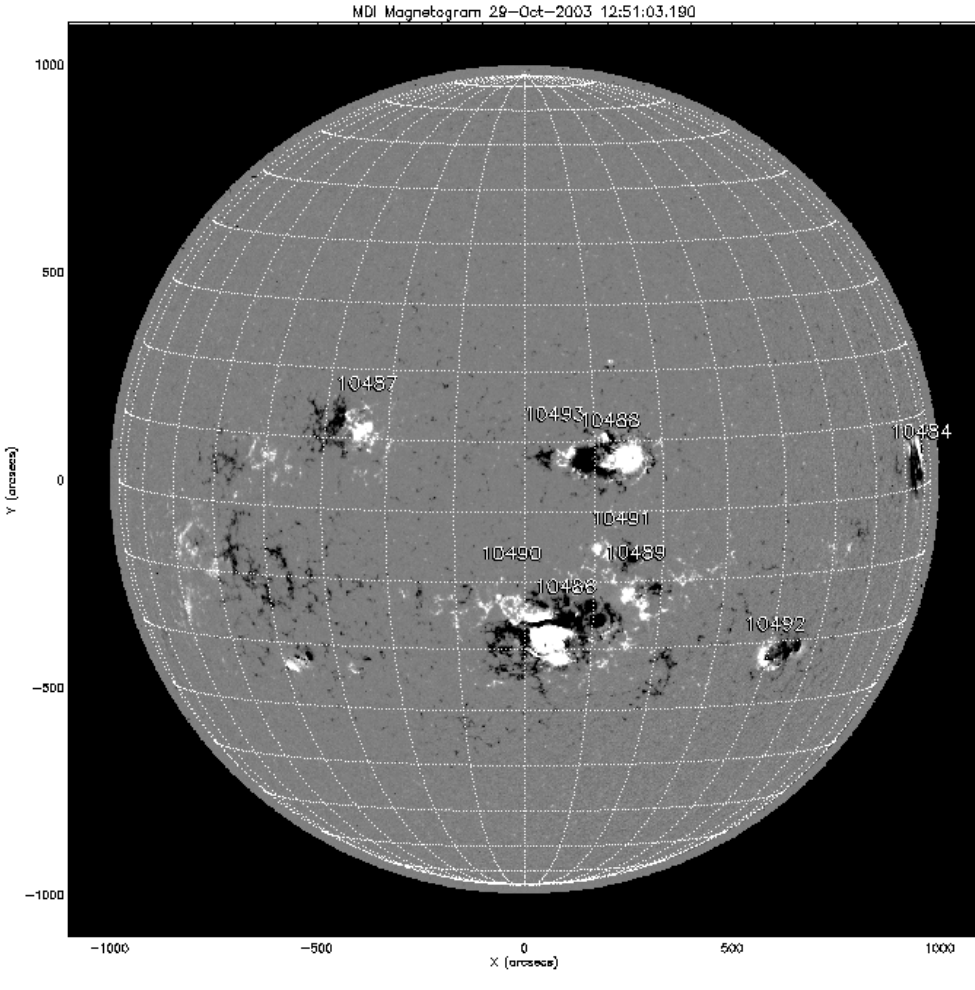
Fig. 6. Magnetogram showing the solar magnetic field on 28 October 2003, at about 12:51UT. The huge active region 486, responsible for the space weather event resulting in the blackout in Malm¨o, is located in the middle just south of the solar equator (Courtesy MDI/SOHO